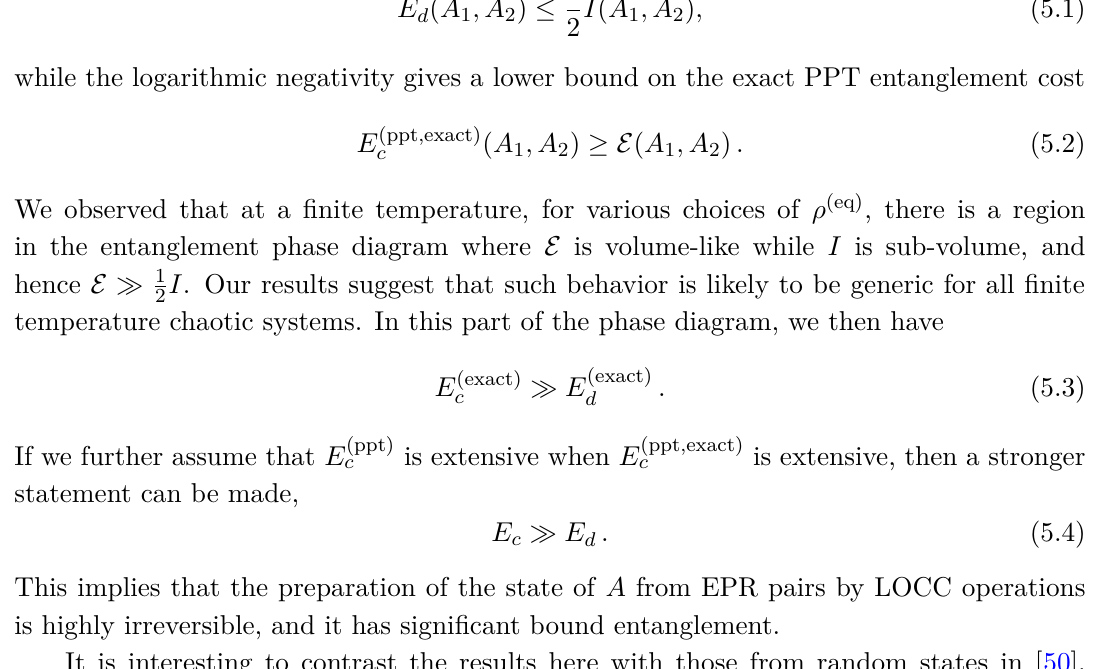
= 2 , 4 , and 6 . The topological transition B = 2 and N = 6 A 1 A 2